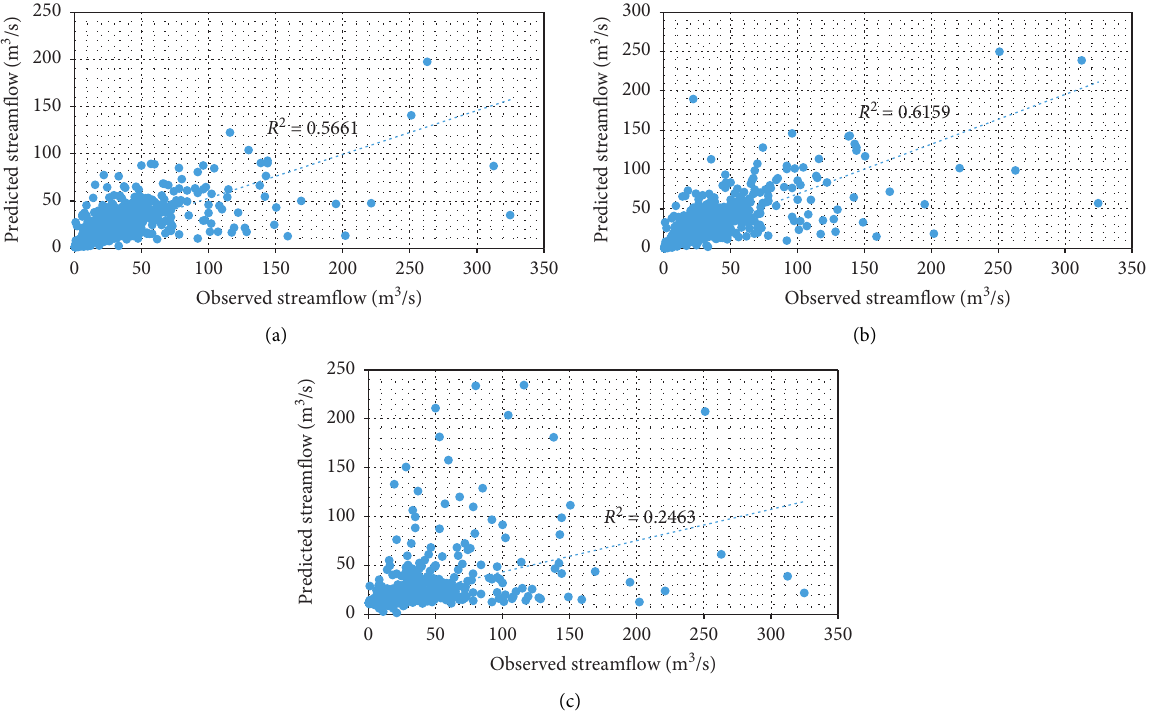
Figure 4: ANN Predicted and observed streamflow: (a) for LM algorithm, (b) for BR algorithm, and (c) for SCG algorithm.